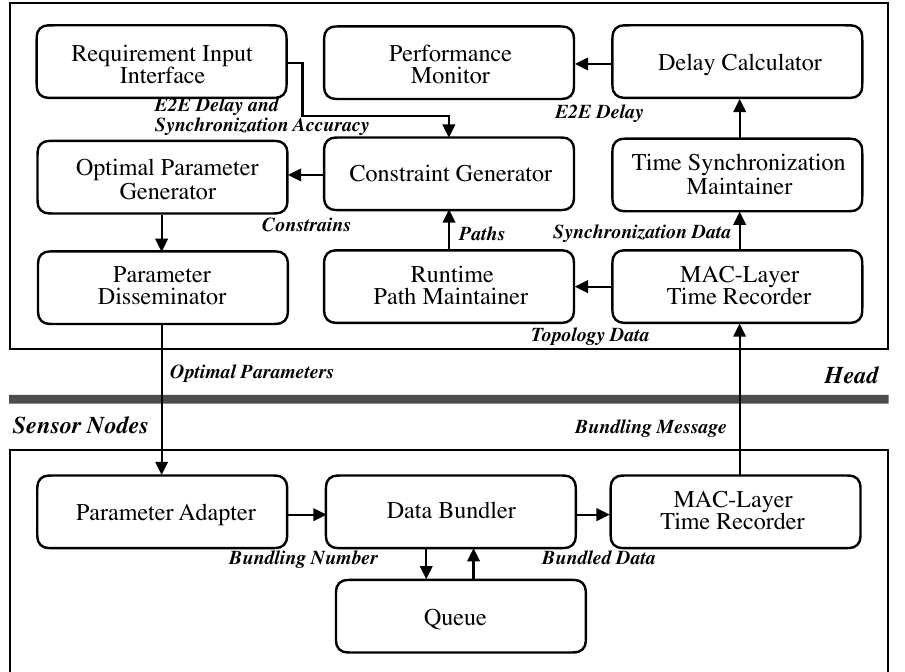
Figure 4. System architecture of the proposed optimal